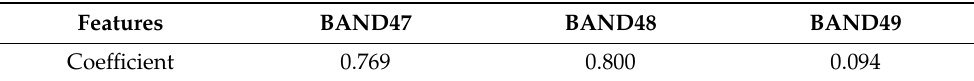
Table 6. Interactive feature coefficients of